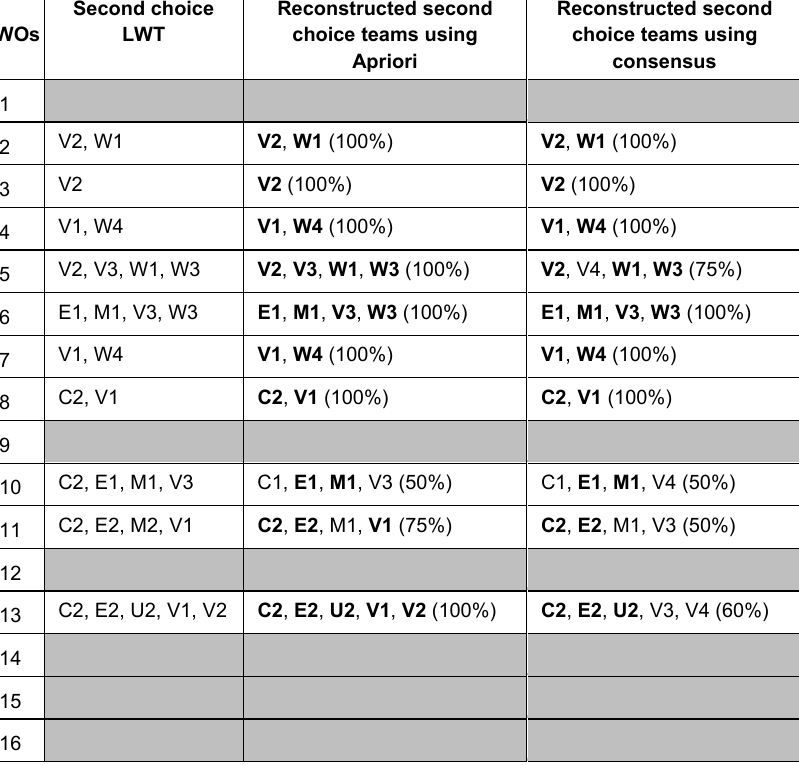
Table 7. Second choice teams and their